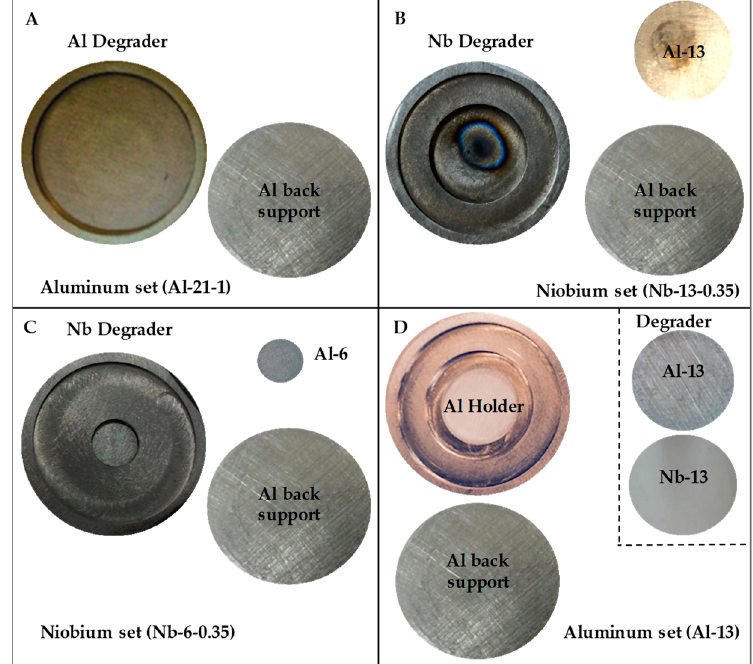
Figure 1. Photographs of the CIMS’ (Sherbrooke Molecular Imaging Centre) custom-made degraders and holder for the 89 Y(p,n) 89 Zr reaction. ( A ) Al degrader with a thickness of 1.0 mm and a hole diameter of 21 mm (Al-21-1). ( B ) Nb degrader with a thickness of 0.35 mm and a hole diameter of 13 mm (Nb-13-0.35). ( C ) Nb degrader with a thickness of 0.35 mm and a hole diameter of 6 mm (Nb-6-0.35). ( D ) Al open window target holder with an inner diameter of 13 mm (Al-13).